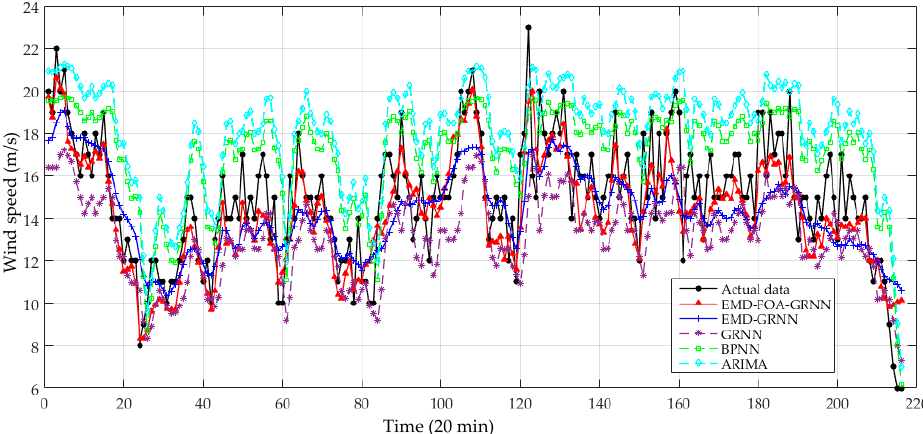
Figure 10. Prediction results of wind speed from 29 November 2011 to 1 December 2011 (II).